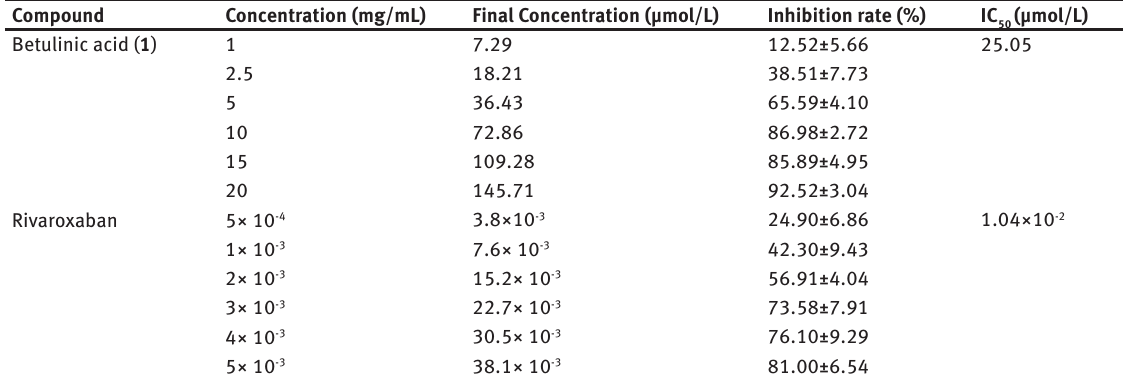
of betulinic acid on FXa. Table 3: IC 50